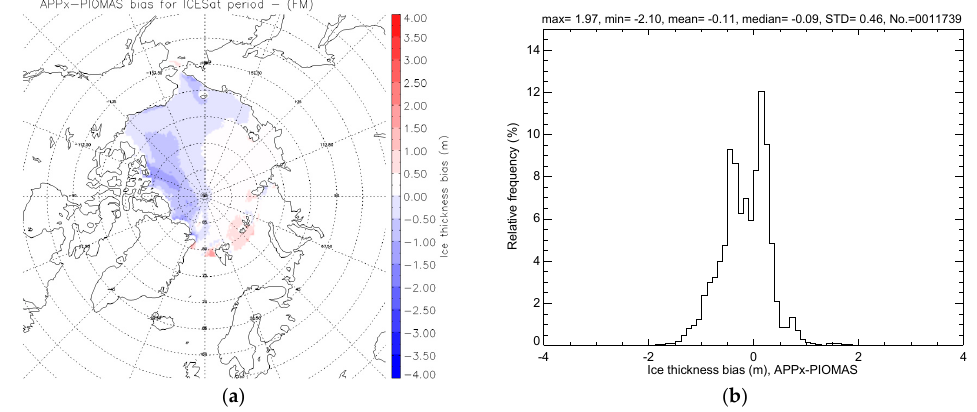
Figure 4. Comparisons in sea ice thickness between APP-x and PIOMAS for the Winter period (FM) over 2003–2008. The bias image in ( a ) is shown on the left, and the bias histogram in ( b ) is shown on the right. The correlation coefficients between APP-x and PIOMAS are 0.67, 0.69, and 0.51 for the periods of FMON, FM, and ON, respectively. ( a ) Bias image between APP-x and PIOMAS; ( b ) Bias histogram between APP-x and PIOMAS.